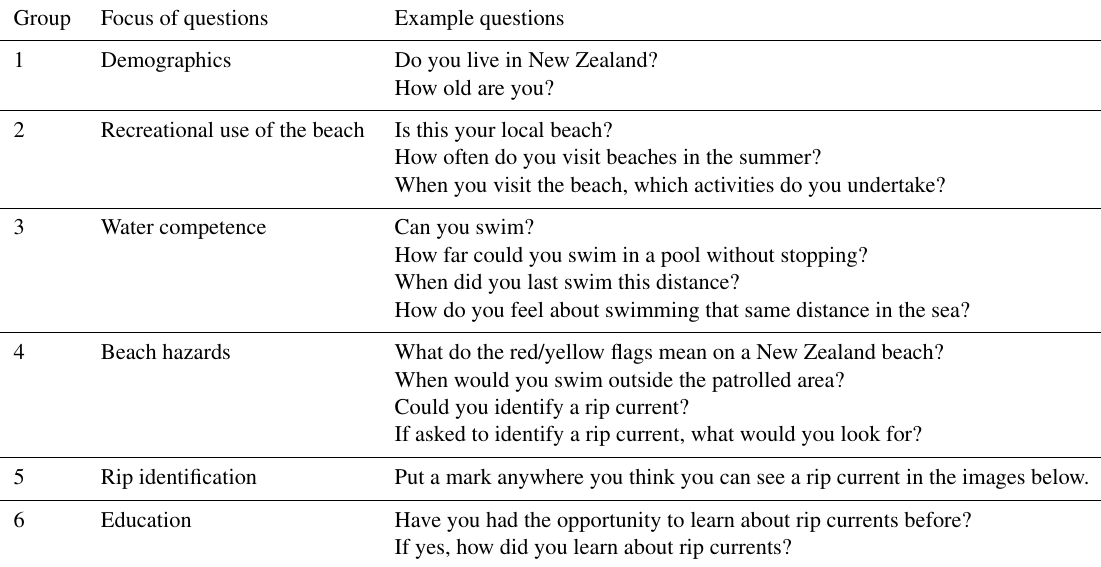
Table 1. Question groups and example questions used in the survey of beach users Group